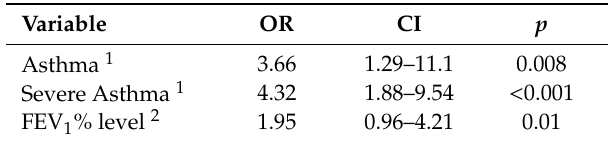
Table 7. Multiple logistic regression analysis of association between asthma, lung function parameters and